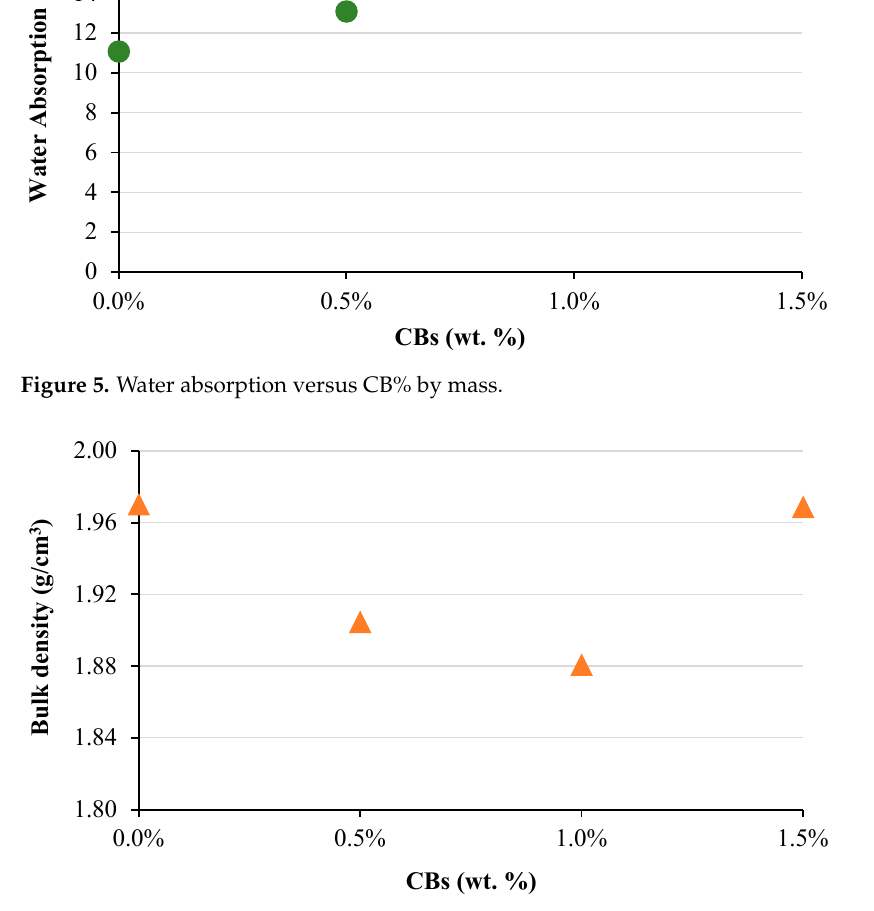
Figure 6. Bulk density versus CB% by mass.